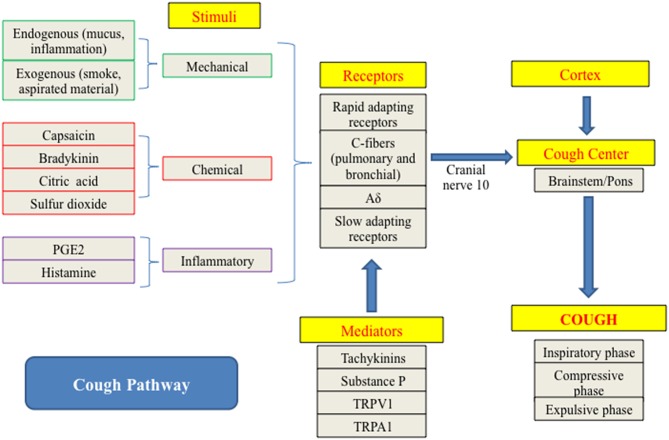
Pathway showing initiation and propagation of the cough response (8, 13, 15, 16).